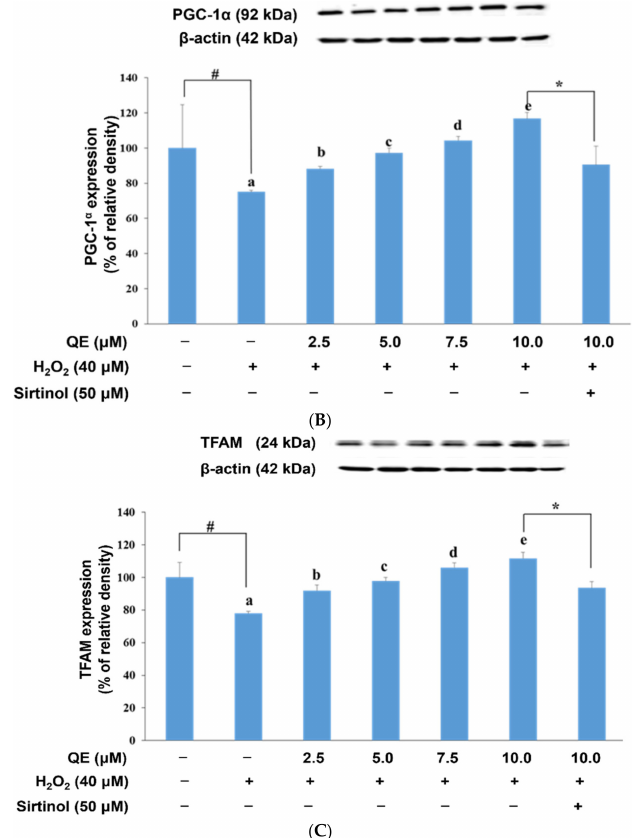
Figure 4. Effects of quercetin and H 2 O 2 on SIRT1 ( A ), PGC-1 α ( B ) and TFAM ( C ) protein expression. Data were presented as mean ± SD. # Data are analyzed using an independent t -test and are significantly different from the control group. * Data are analyzed using an independent t -test and are significantly different from the group added 10 µ M quercetin but without sirtinol. Bars of 0, 2.5, 5.0, 7.5, and 10.0 µ M quercetin with different letters significantly differ. Statistical analysis was performed using a one-way ANOVA, followed by a least significant difference post hoc test ( n =